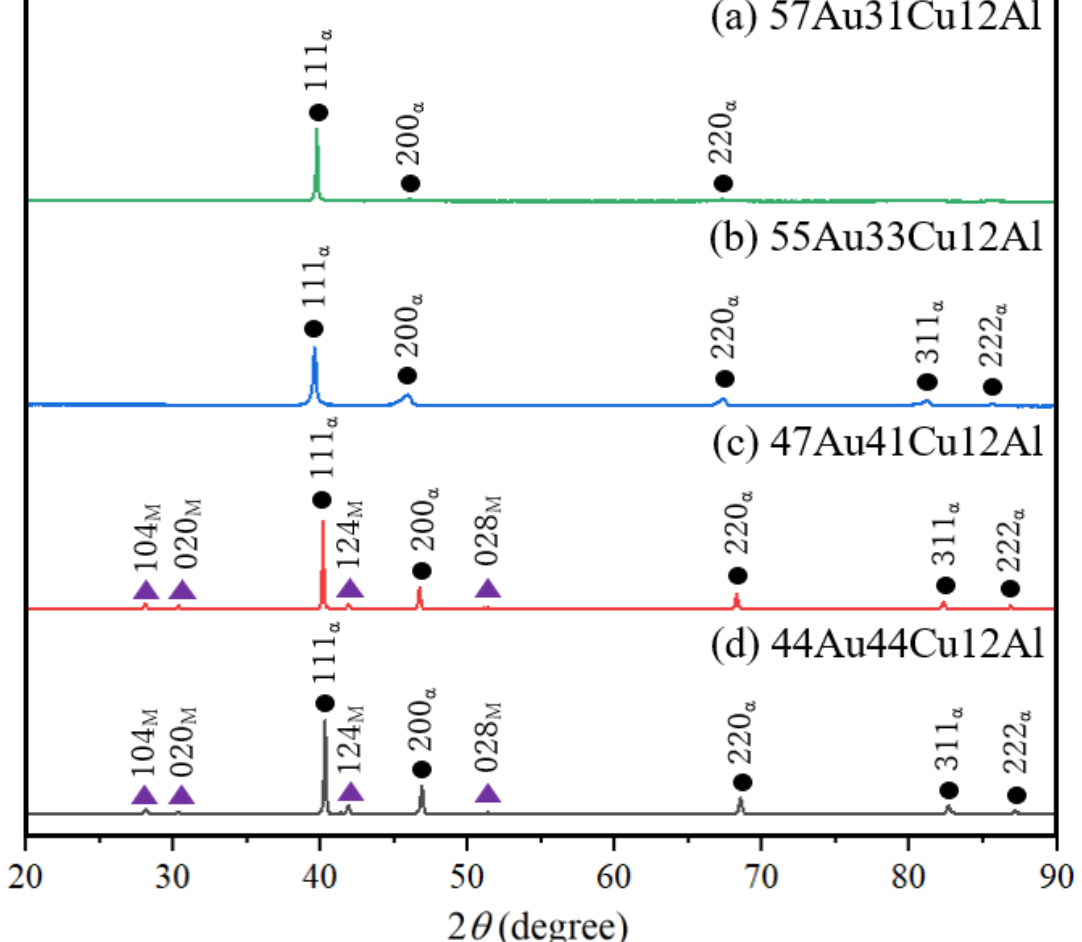
Figure 2. X-ray diffraction patterns of ( a ) 57Au31Cu12Al, ( b ) 55Au33Cu12Al, ( c ) 47Au41Cu12Al, and ( d ) 44Au44Cu12Al alloys at 293 K ( ± 3 K). (The subscript of α indicates the α -phase and the subscript of M suggests the DB19 martensite phase) .